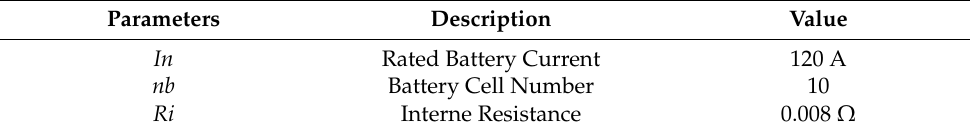
Table 4. Battery